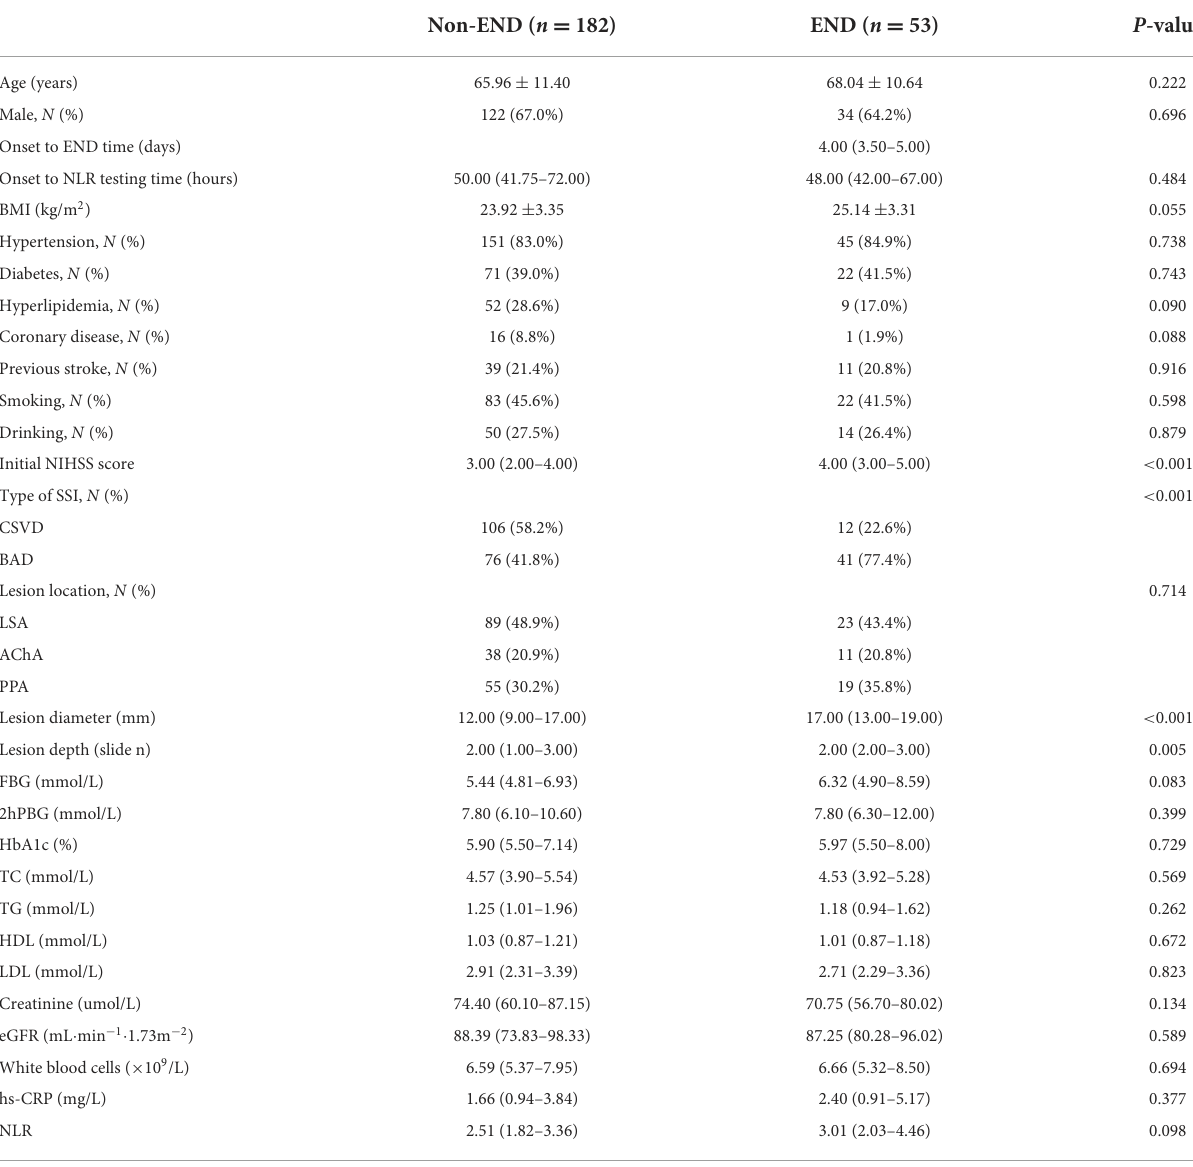
TABLE 1 Clinical characteristics of general patients in the non-END and END groups.